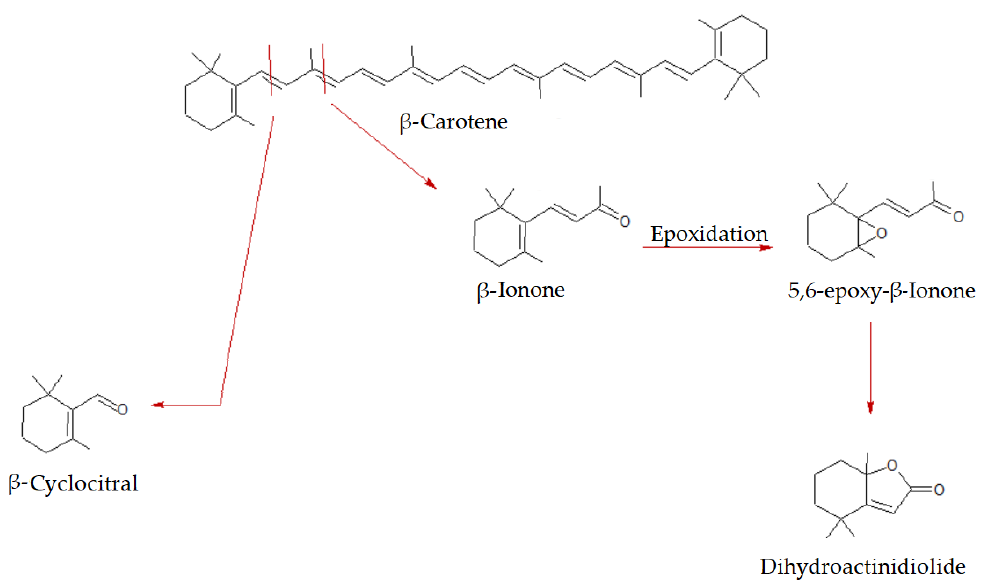
Figure 7. Proposed biosynthetic pathway for watermelon volatiles and their counterparts: β-carotene degradation.